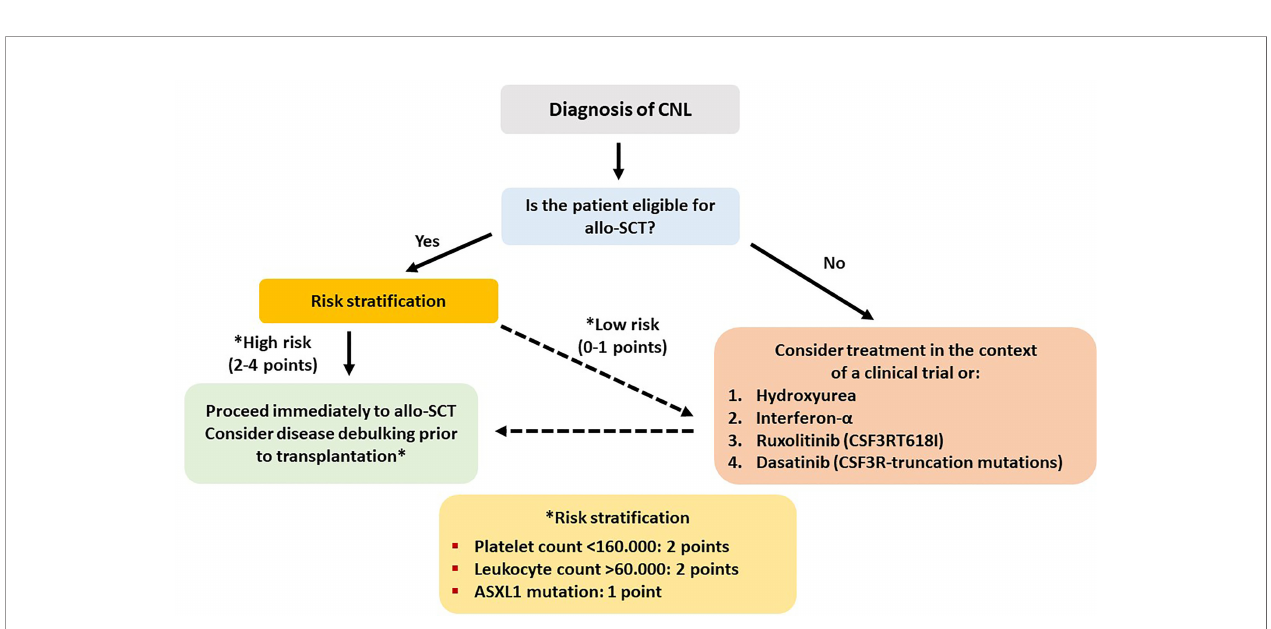
FIGURE 4 | Recommended treatment algorithm for patients with chronic neutrophilic